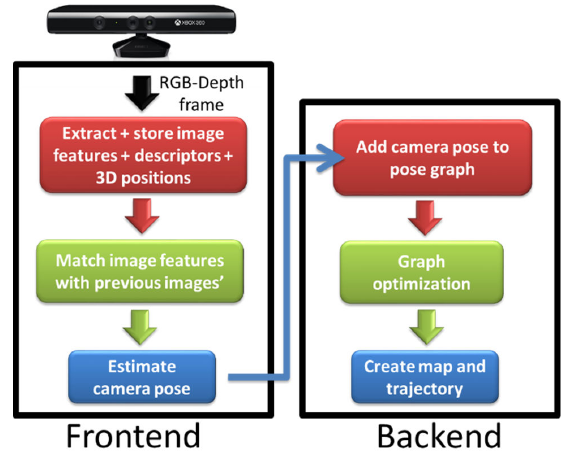
Figure 5. RGB-D SLAM’s workflow for pose estimation and map creation.